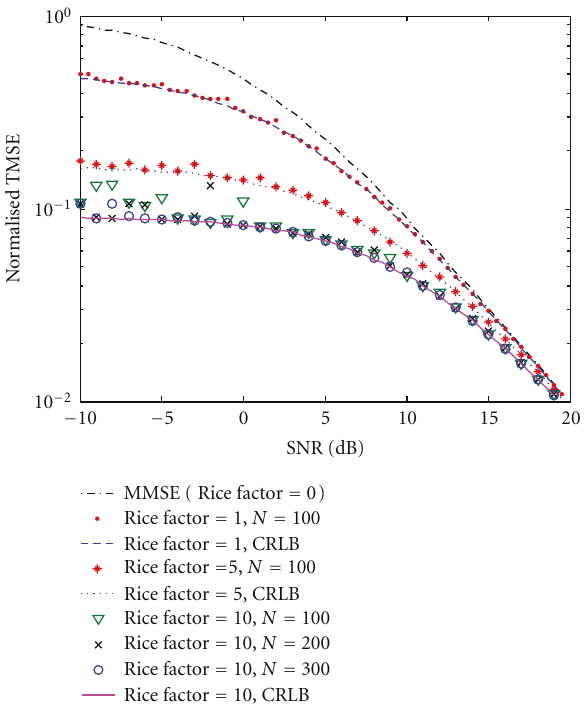
Figure 12: Normalized TMSE of the MMSE estimator by using the Rice factor estimation algorithm ( N T = N R = 2, L = 1, N P =